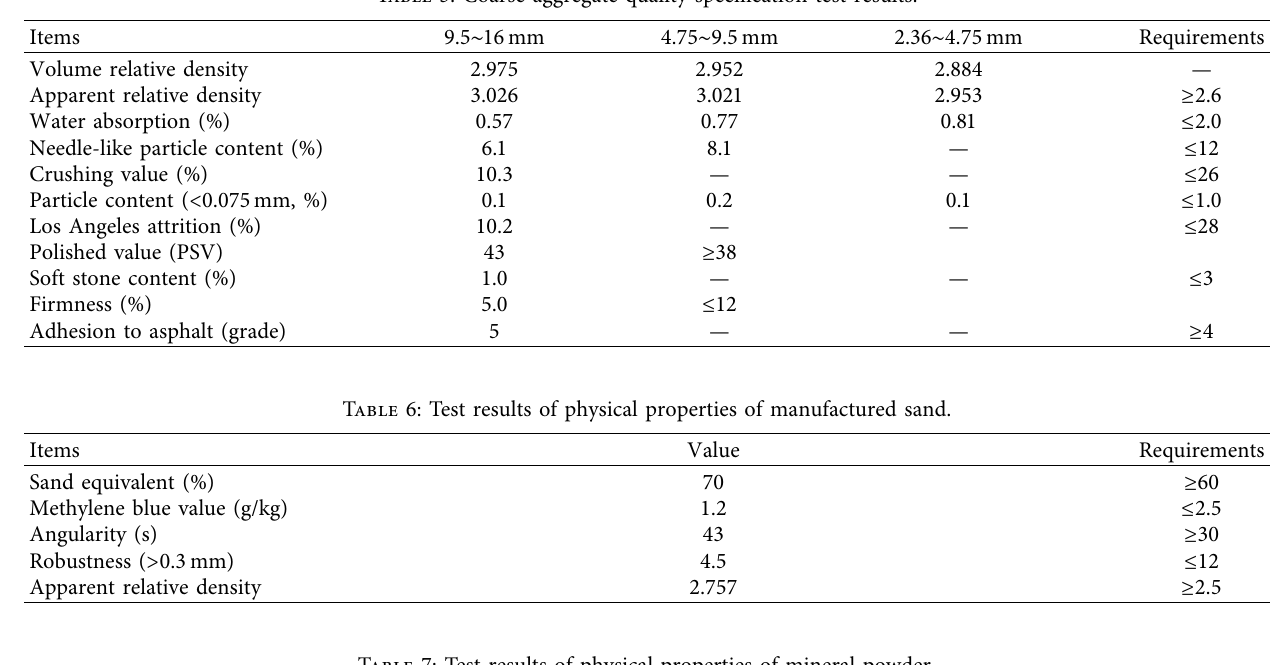
Table 5: Coarse aggregate quality specification test results.